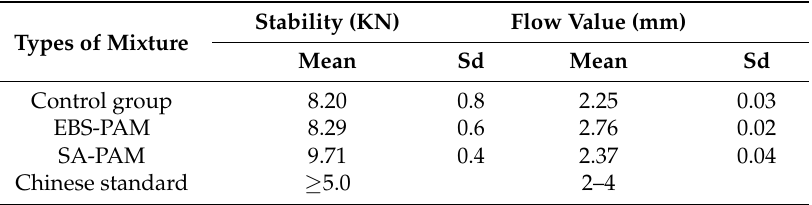
Table 5. Marshall stability and flow value.